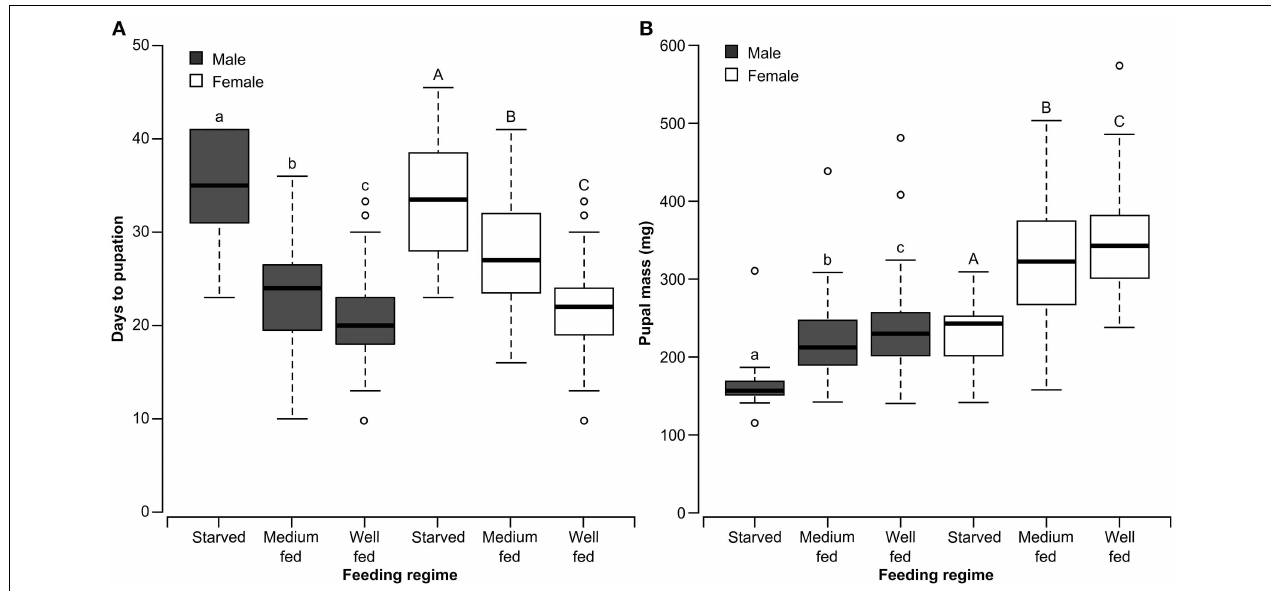
FIGURE 4 | Box and whisker plots of the days to pupation (A) and pupal mass (B) of male and female forest tent caterpillars reared on different quantities of artificial diet. The first and third quartiles are represented by the top and bottom of the box, respectively. The midline